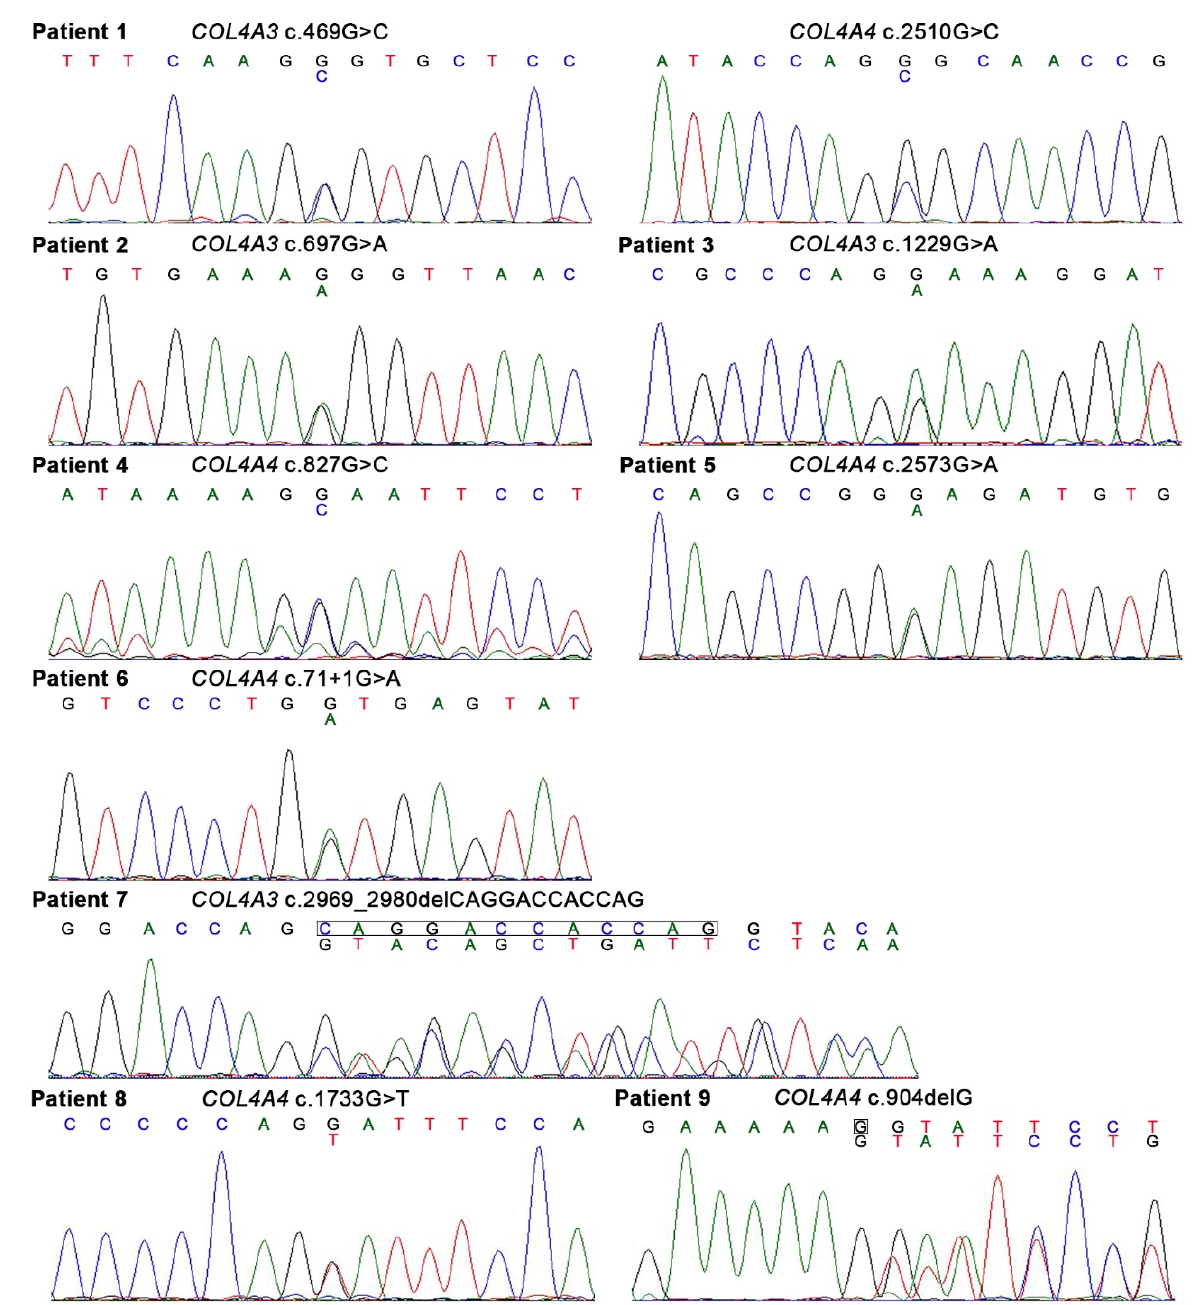
Figure 1. Heterozygous variants of COL4A3 or COL4A4 identified in the present study. Of 10 variants in COL4A3 or COL4A4 , 8 were single nucleotide variants and 2 were deletion variants. There was a splice-site single nucleotide variant in Patient 6. Patient 1 had digenic variants ( COL4A3 c.469G > C and COL4A4 c.2510G > C).